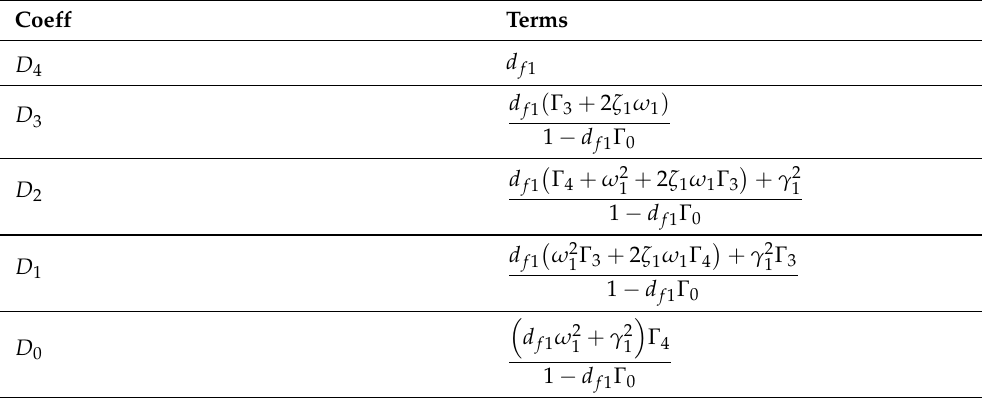
Table 2. Numerator coefficient table. Coeff